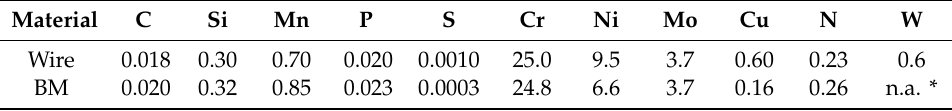
Table 1. Chemical composition of selected filler wire and support plate. (Fe is